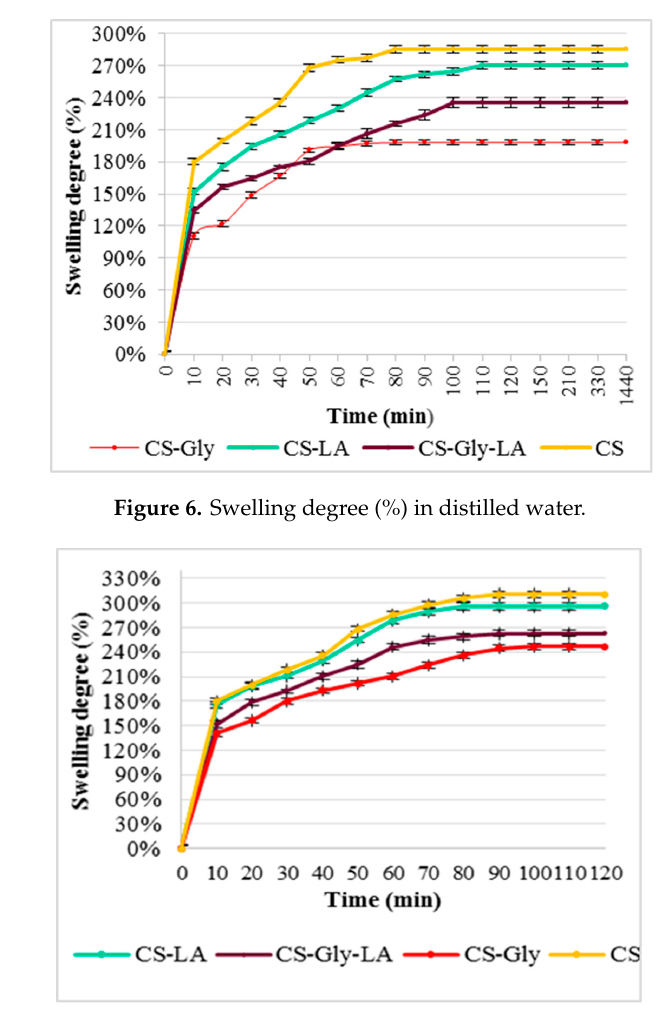
Figure 5. EE% and DL% for the systems type CS–Gly–LA systems.